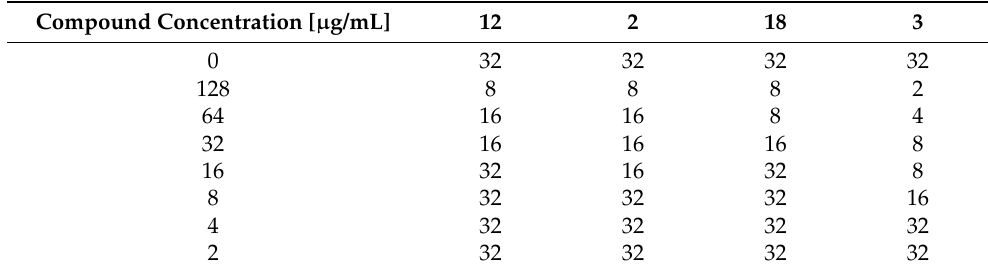
Table 2. Effects of 2 , 3 , 12 , and 18 at various concentrations on MICs of imipenem for the clinical K. pneumoniae isolate expressing NDM-1.